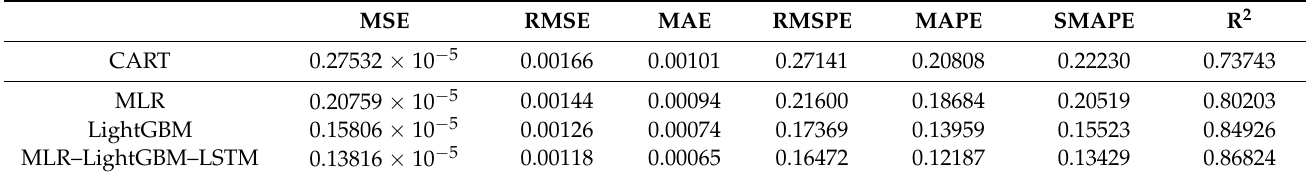
Figure 20. Model bias comparison (a-g are seven different evaluation metrics.). Table 4. Model bias comparison (Based on test sets).